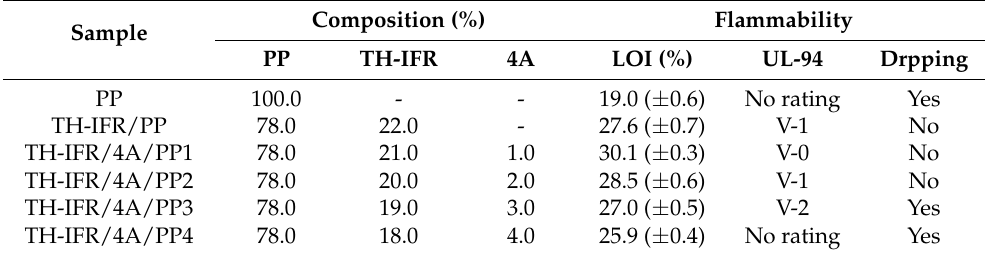
Table 1. Formulation and flammability of pure PP and PP composites.